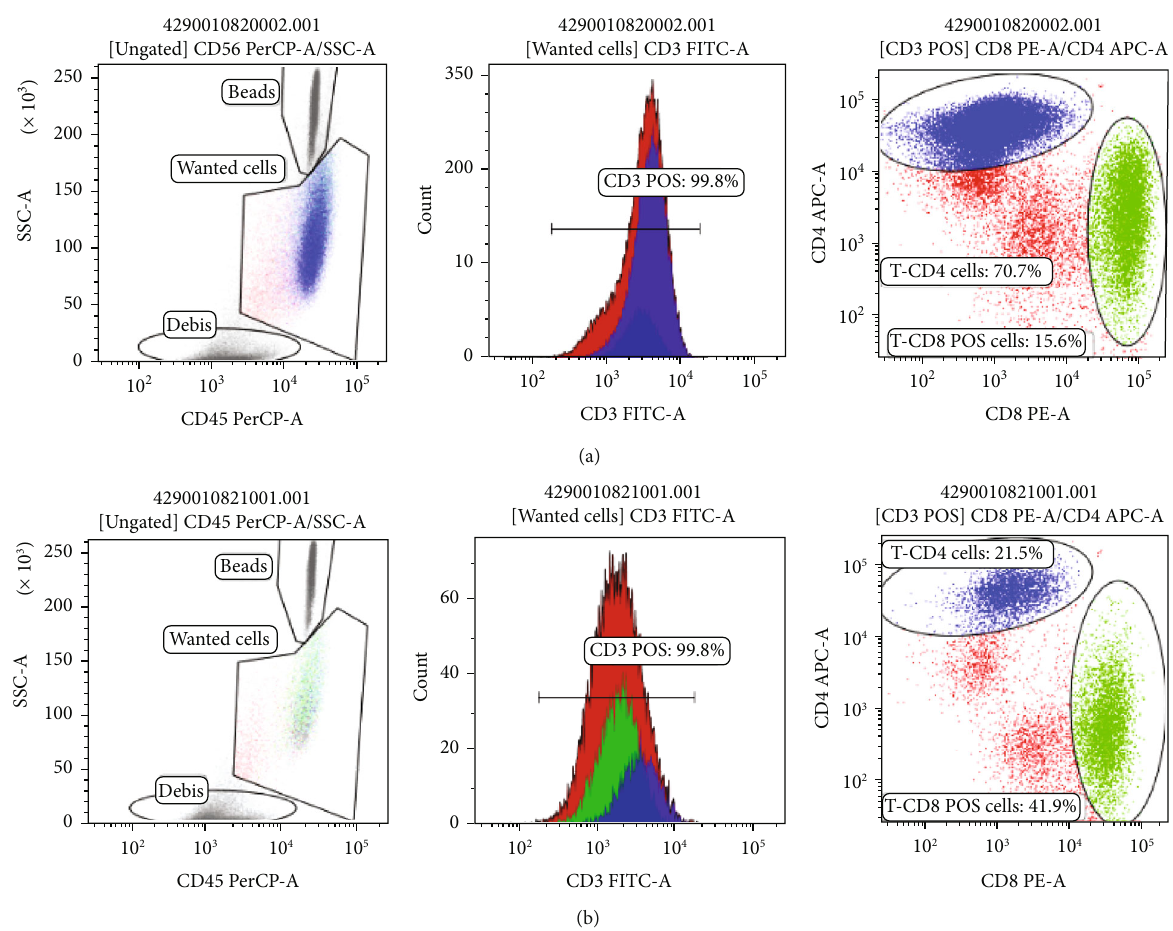
Figure 4: Flow cytometry results of transgenic – CAR-T cells (a) and T-lymphocytes (nontransgenic) after 14 days of culture (b).